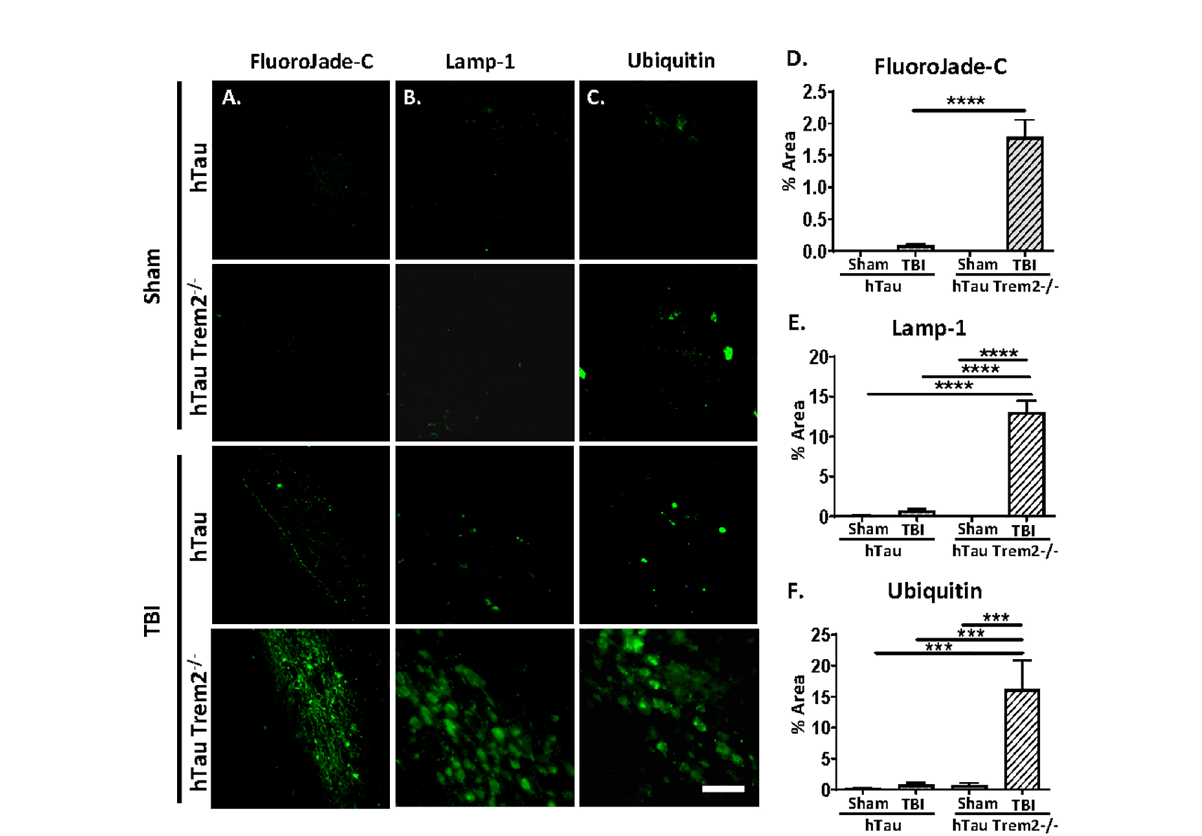
FIGURE 5 The swollen dystrophic neurons in the white matter in hTau; Trem2 -/- TBI mice in the chronic phase. Representative images of FluoroJade-C ( column A ), Lamp-1 ( column B ), and ubiquitin ( column C ) from hTau and hTau Trem2 -/- mice with or without TBI. (D – F) A signi fi cant increase in neurodegeneration was found in hTau; Trem2 -/- TBI mice. ND. Not detected. All experiments used n = 6 (equal males and females) mice per group unless otherwise noted. At least two independent experiments were performed for each analysis. The scale bar represents 50 m m. Error bars indicate SEM; *** p <0.005, **** p